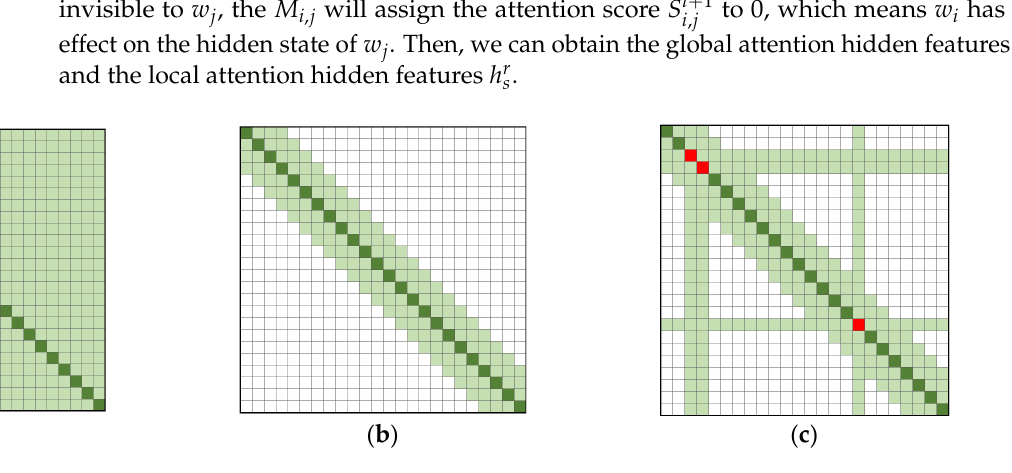
(cid:0) (cid:1) µ 2 ; ( b ) Local